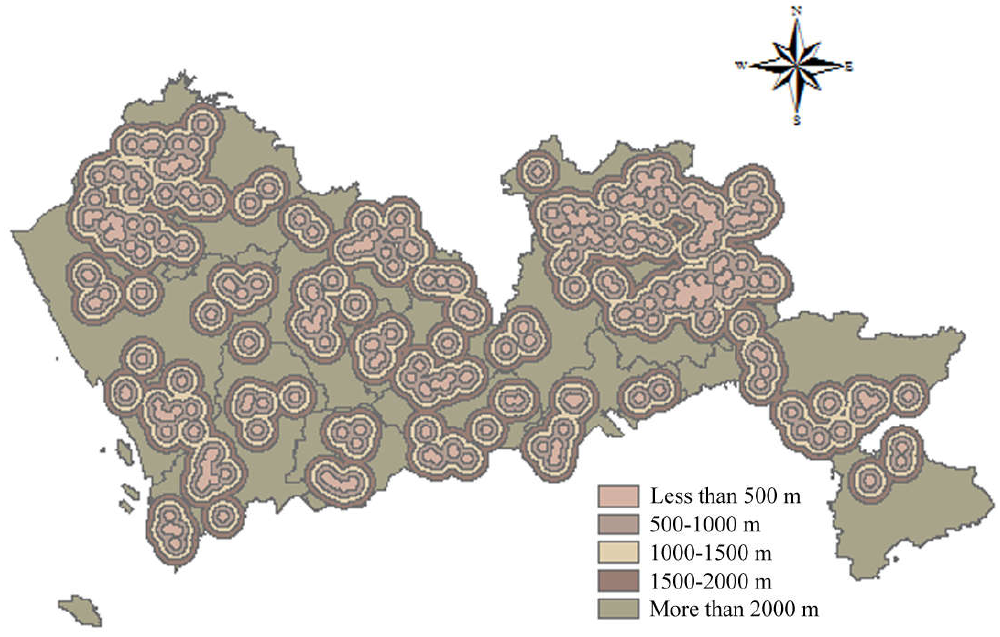
Figure 11. Map of distance to historical relics.